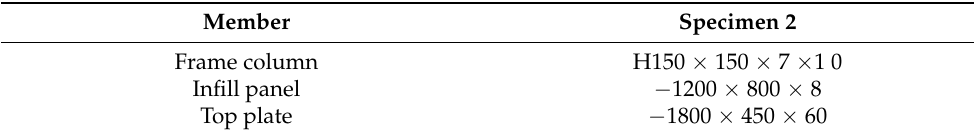
Table 8. The section size of specimen 2 (units: